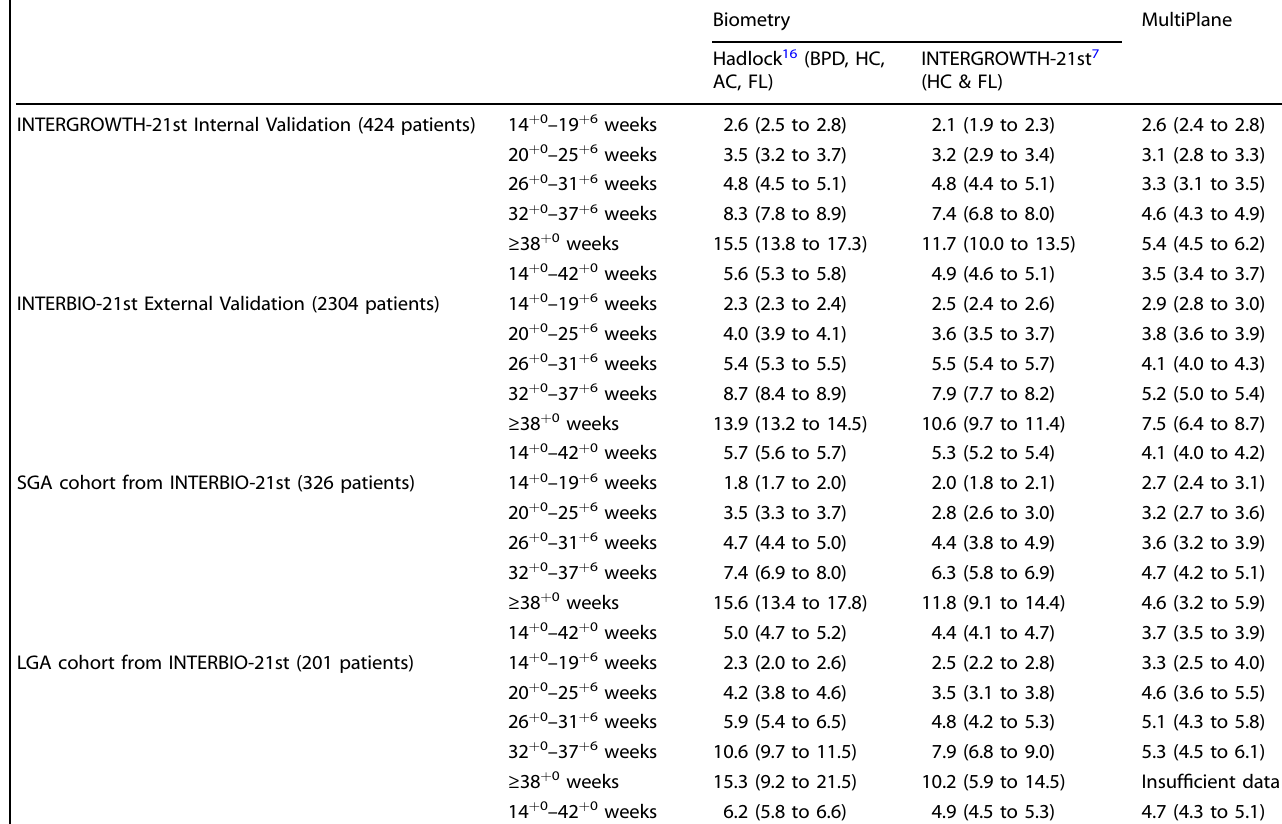
Table 3. Table showing comparison of MultiPlane performance to biometry-based methods of gestational age estimation throughout gestation.